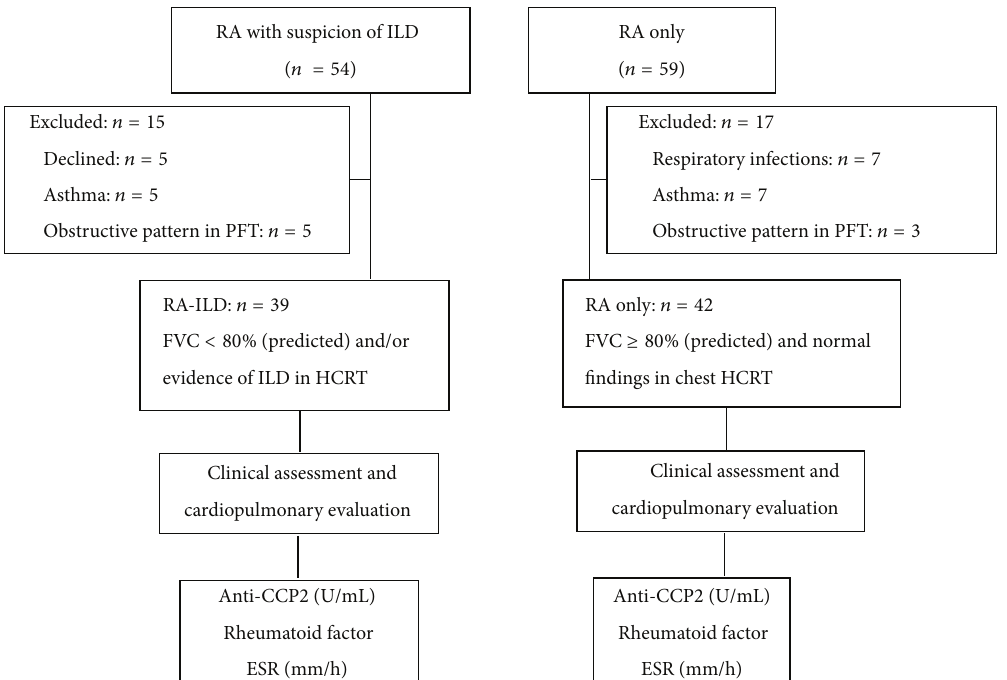
Figure 1: Study flow chart. RA: rheumatoid arthritis; RA-ILD: rheumatoid arthritis with interstitial lung disease; PFT: pulmonary function tests; HRCT: high-resolution computed tomography; FVC: forced vital capacity; anti-CCP: anti-cyclic citrullinated peptide antibodies; ESR: erythrocyte sedimentation